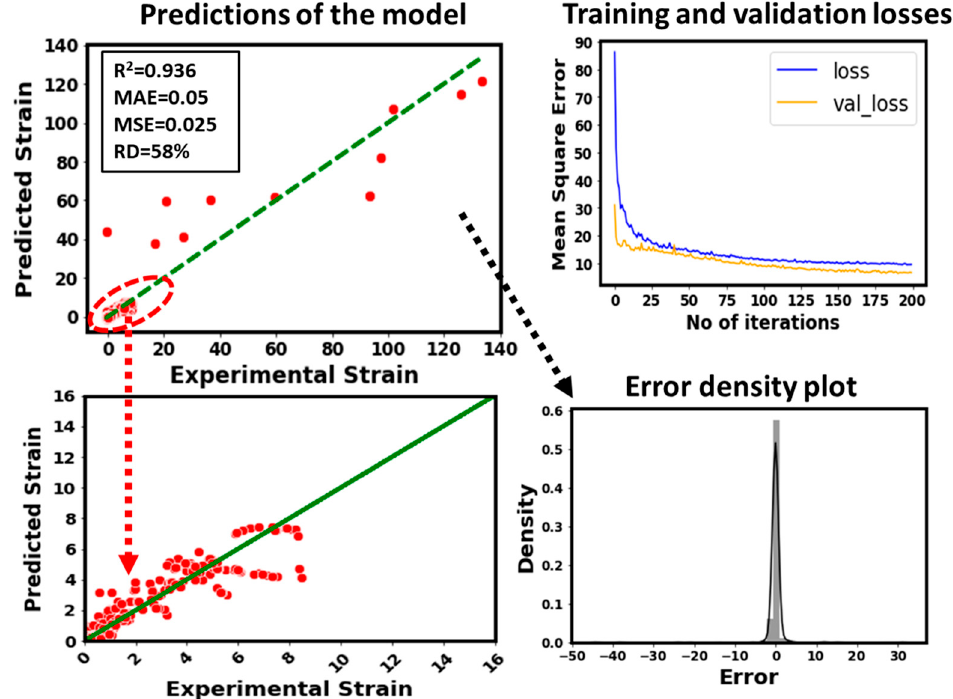
Figure 6. Predictive performance of the developed DL model.